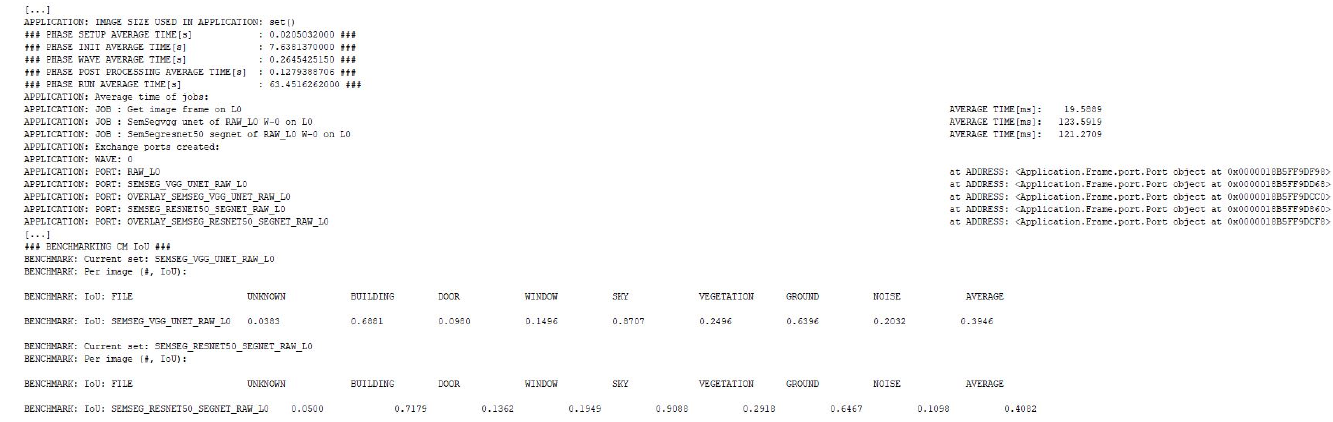
Figure 19. Console output of training evaluation and IoU